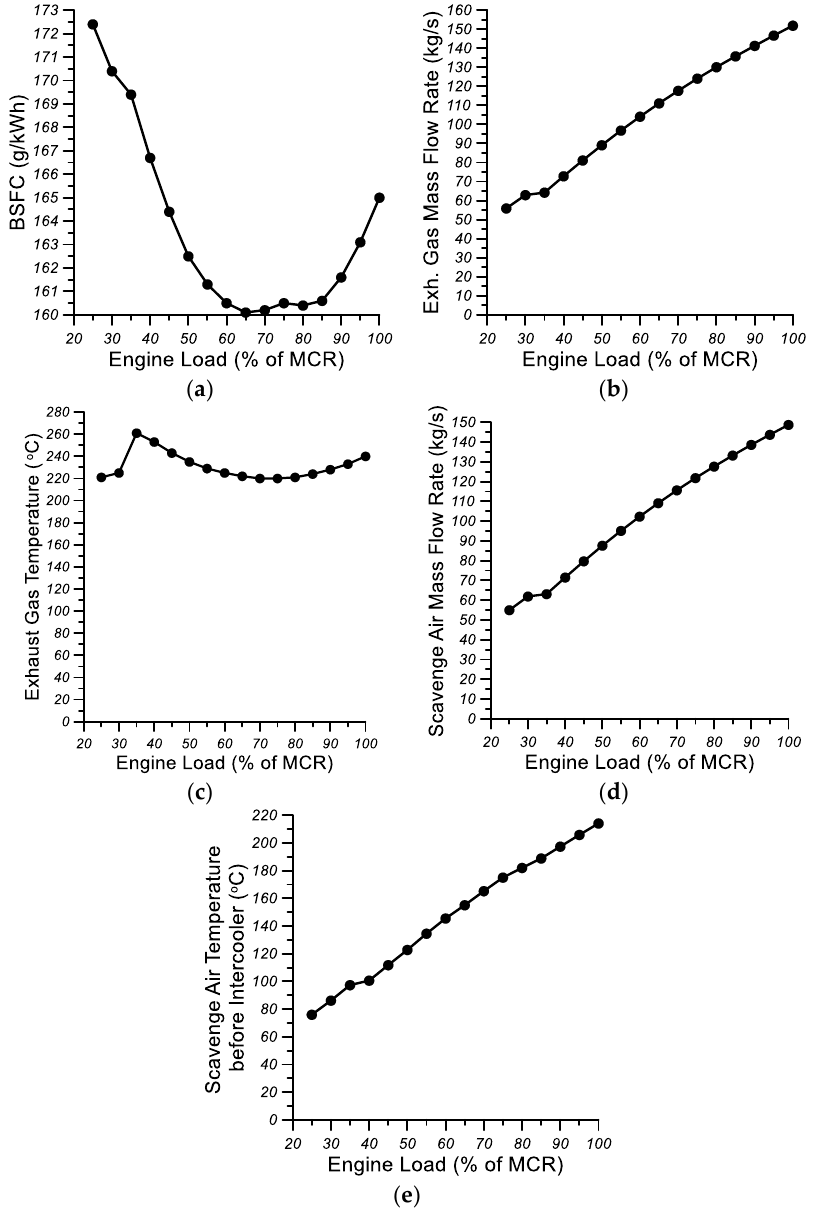
Figure 1. Variation of ( a ) BSFC, ( b ) exhaust gas mass flow rate, ( c ) exhaust gas temperature, ( d ) scavenge air mass flow rate, and ( e ) scavenge air temperature before the intercooler with engine load. Experimental results are given for a two-stroke main marine diesel engine using data adopted from Ref.